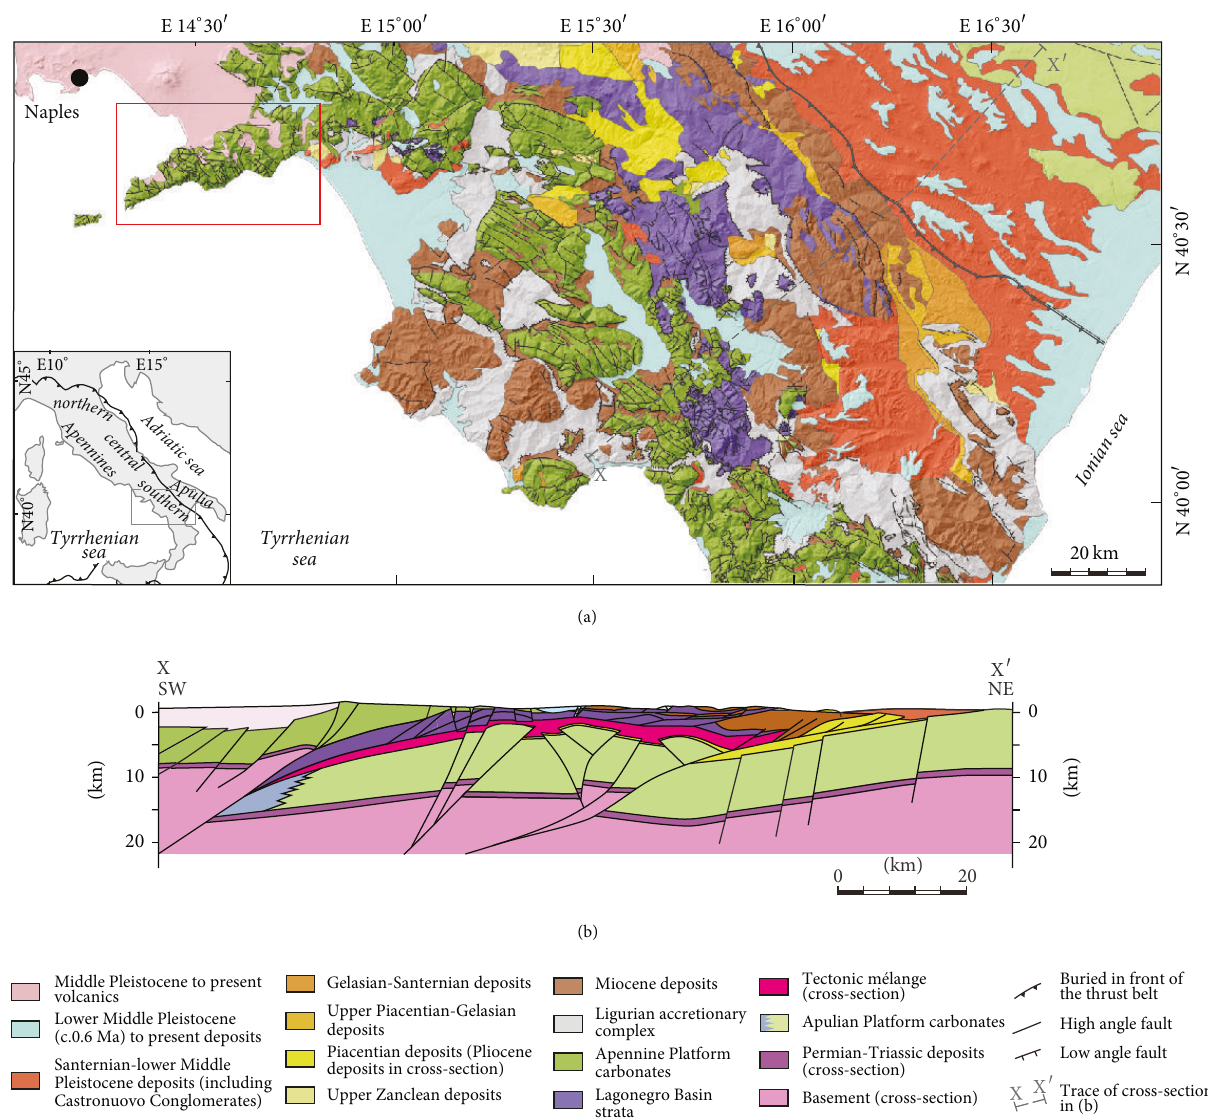
Figure 1: Geological sketch map of the Southern Apennines (after [36]; modified). Red box shows the study area. The regional cross-section X-X 󸀠 shows the tectonic unit analysed (Apennine Platform carbonates) and the buried analogue unit (Apulian Platform carbonates).